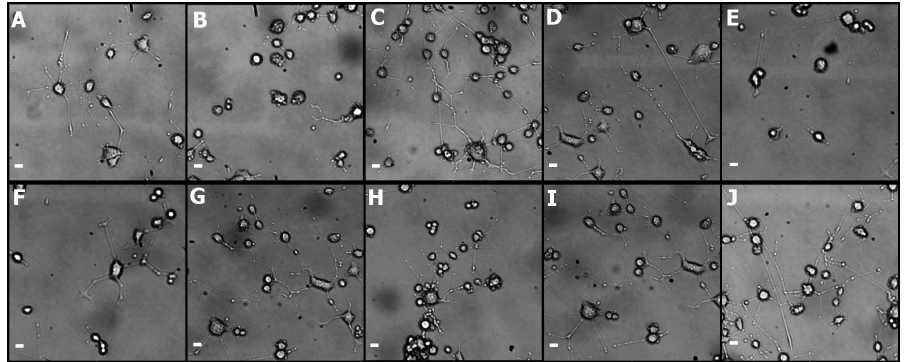
Figure 5. Differentiation of PC-12 cells in the presence of NGF. Photomicrographs representative of different hydrogels. ( A ) Differentiation control medium; ( B ) Pluronic F127; ( C ) Pluronic F127/Pluronic F127-Chitosan 10%; ( D ) Pluronic F127/Pluronic F127-Chitosan 15%; ( E ) Pluronic F127 DPPC liposomes; ( F ) Pluronic F127 DMPC liposomes; ( G ) Pluronic F127/Pluronic F127-Chitosan 10% DMPC liposomes; ( H ) Pluronic F127/Pluronic F127-Chitosan 10% DPPC liposomes; ( I ) Pluronic F127/Pluronic F127-Chitosan 15% DPPC liposomes; ( J ) Pluronic F127/Pluronic F127-Chitosan 15% DMPC liposomes. The bar in the photomicrographs corresponds to 20 μ m.